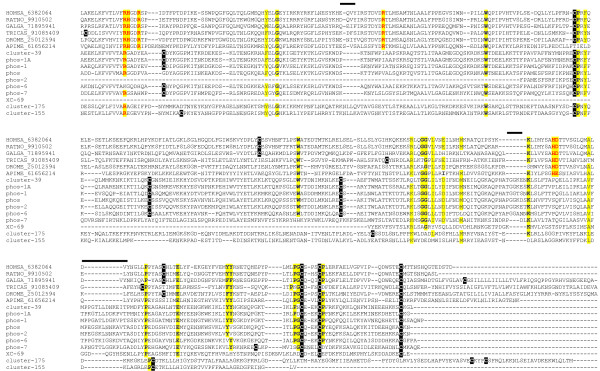
Alignment of human, rat, chicken, beetle (Triboleum castaneum), fly (Drosophila melanogaster), bee and flea acid phosphatase sequences. The red letters over yellow background indicate amino acids found in the active center of rat and human enzymes. Other yellow background indicated identical (in bold) or conserved amino acids. The bars indicate regions of insertion/deletion when the flea and remaining sequences are compared. Cysteines are shown in white font over black background.